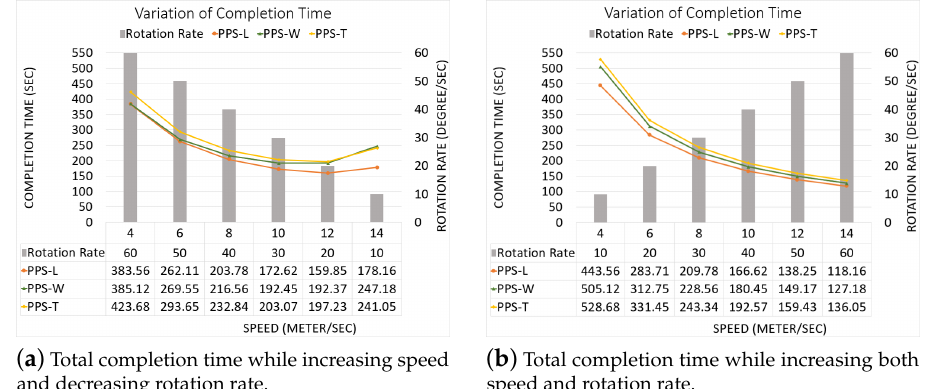
Figure 26. The variation of the total completion time in each area.